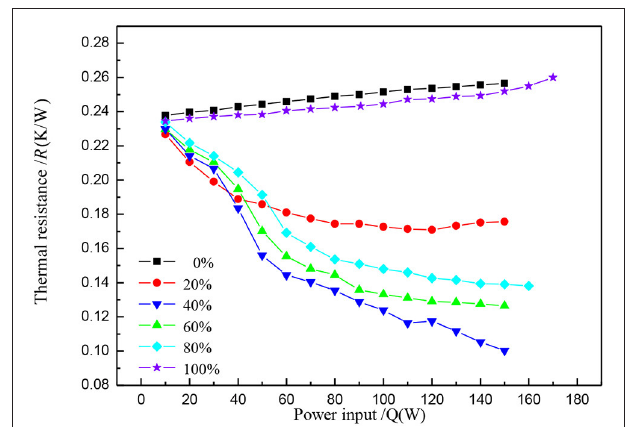
FIGURE 7 | Thermal resistance variation with the change in heat input of the different mediums of FPHP.